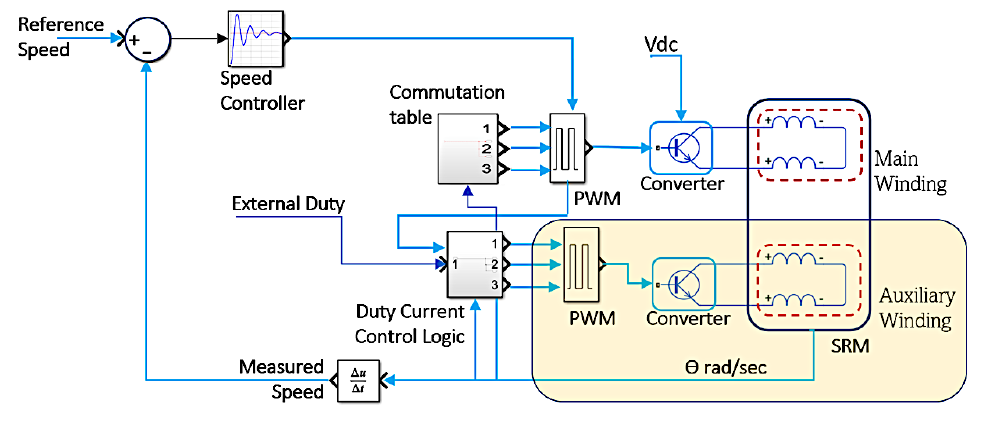
Figure 3. Block diagram of the proposed HESRM without permanent magnet excitation.